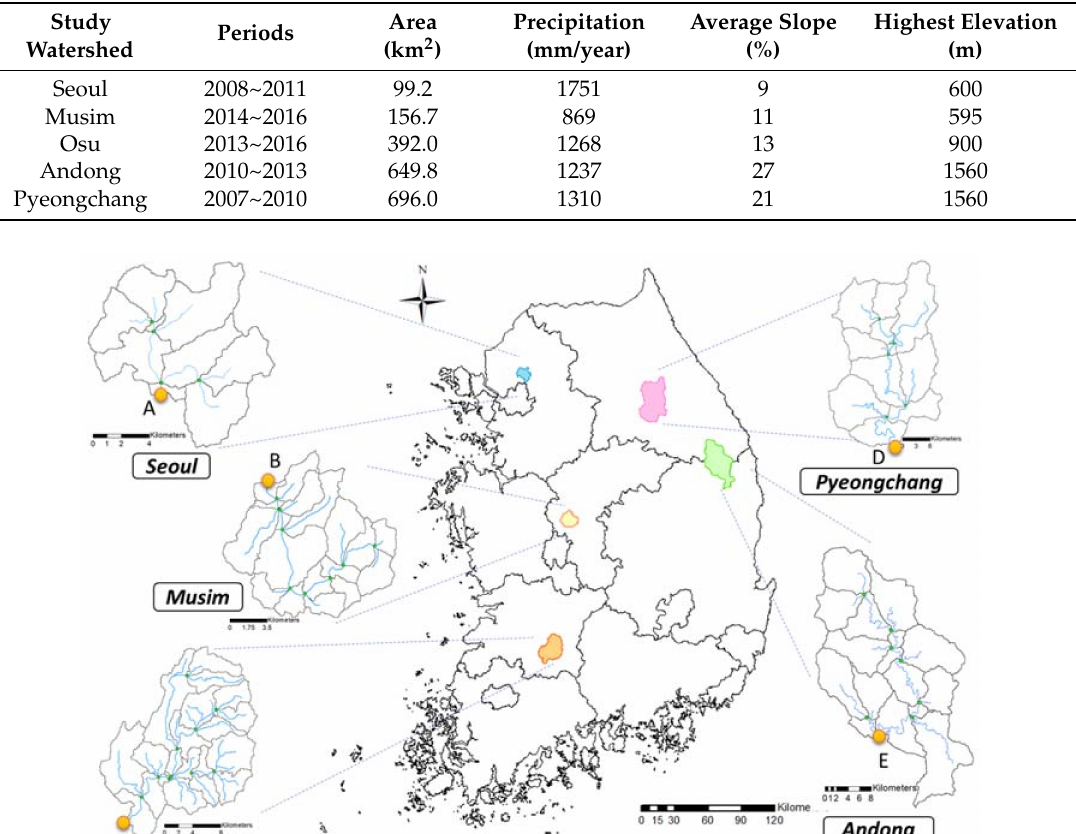
Table 1. Characteristics of five study watersheds in South Korea.